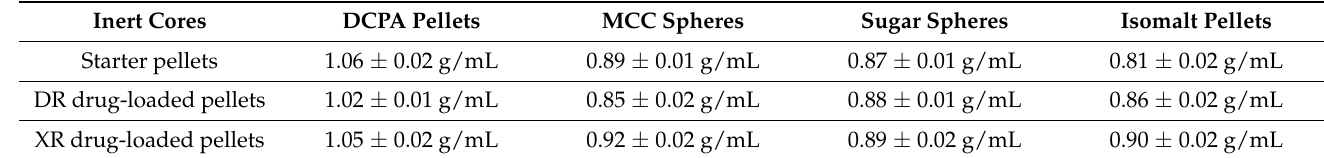
Table 2. Comparison of the bulk density of starter and drug-loaded pellets (mean of 3 independent determinations). Inert Cores